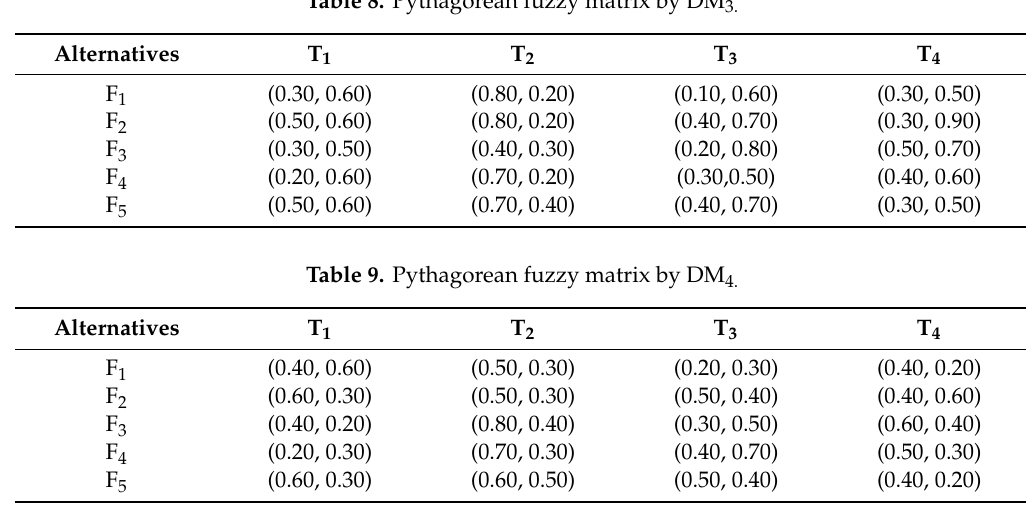
Table 10. Pythagorean fuzzy matrix by DM